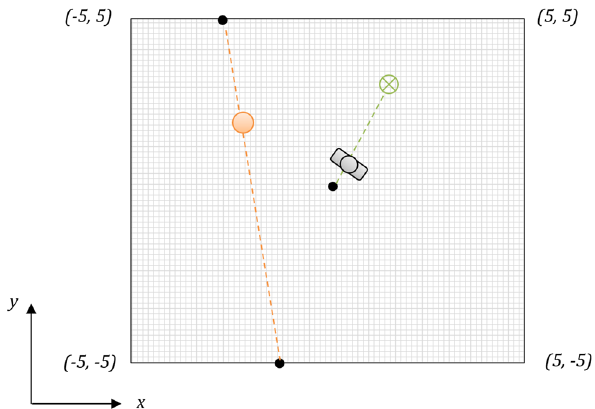
Figure 2: Learning task training environment.